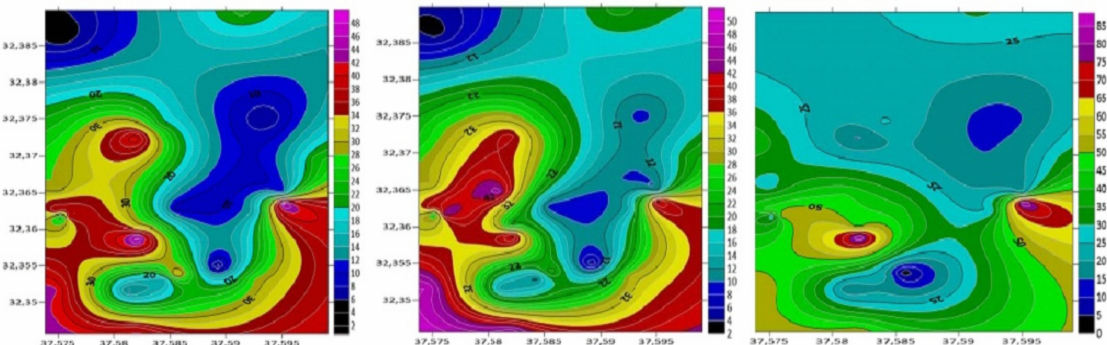
Figure 2. Surfer map of PM 10 values ( µ g/m 3 ) measured in the morning (Concentration, Average, Maximum).